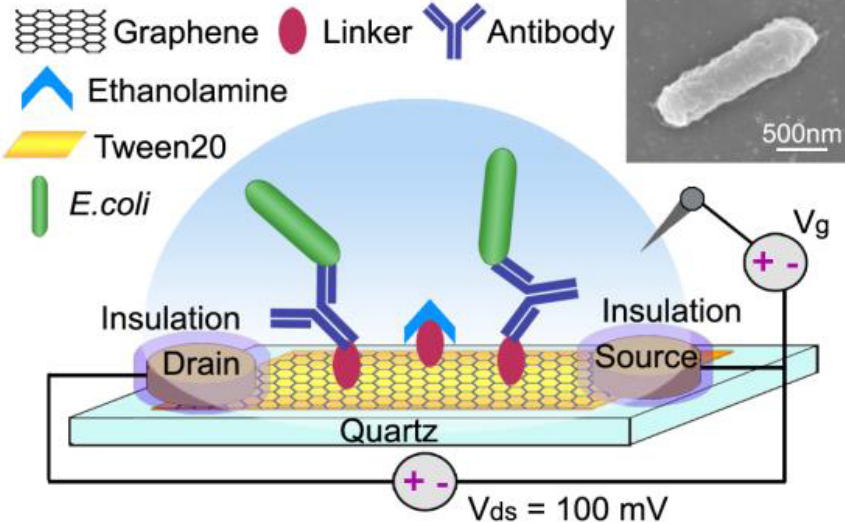
Figure 6. Schematic diagram of anti- E. coli antibody functionalized graphene-field-effective transistor (FET), inset: SEM image [41].